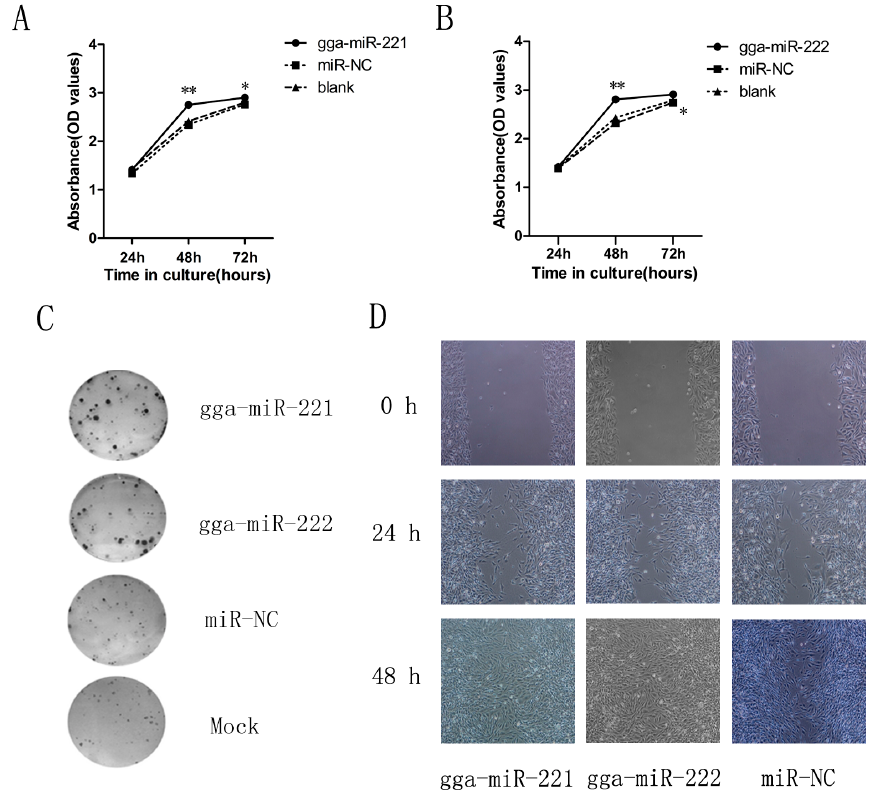
Figure 2. gga-miR-221 and gga-miR-222 promoted DF-1 cell proliferation and invasion. Cells were transfected with gga-miR-221, gga-miR-222, miR-NC, or mock transfected and then underwent WST-1 analysis, wound healing assay, and colony formation assay. ( A ) and ( B ) The effects of gga-miR-221 and gga-miR-222 on proliferation were detected using WST-1 analysis over 48 h. The figures show the means and standard errors from three independent experiments; * P value ( p) ** p <